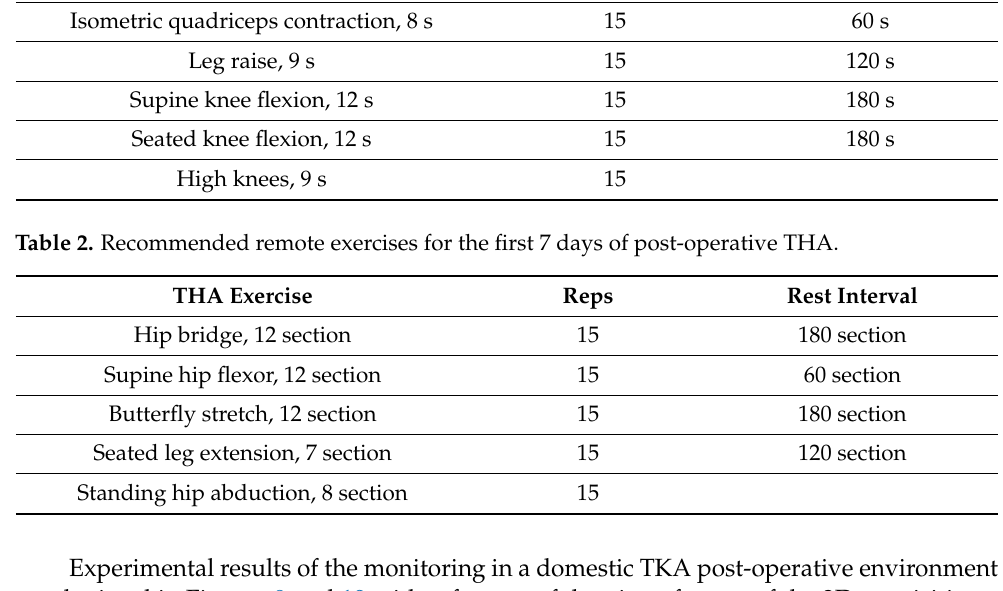
Table 1. Recommended remote exercises for the first 7 days of post-operative TKA.